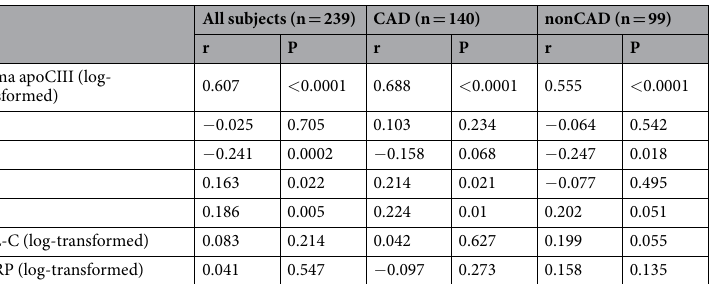
All subjects (n = 239) CAD (n = 140) nonCAD (n = 99)